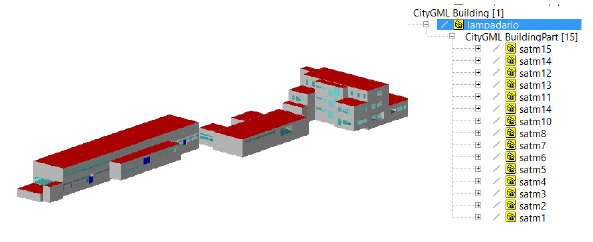
Figure 4. LoD3 building of NTUA campus